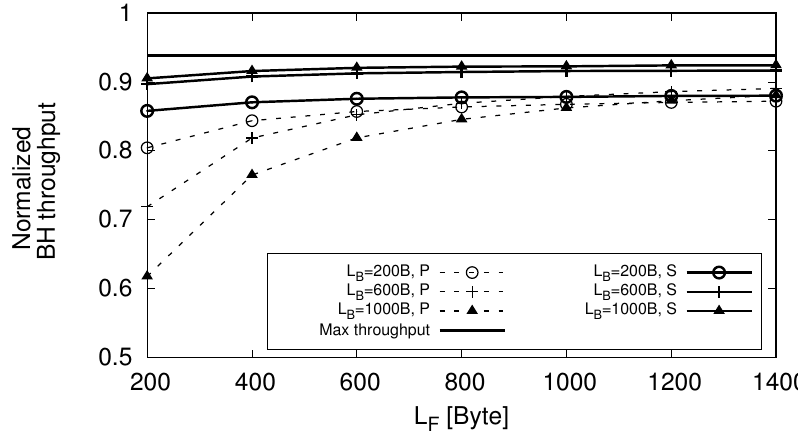
Figure 6. Backhaul (BH) throughput, normalized to the output link capacity, as a function of payload length L F for different BH packet length L B using CPRI opt. 1. Solid lines for the case with segmentation (S), dashed lines for the no-segmentation case (P). Maximum normalized capacity by fronthaul (FH) is shown by a solid